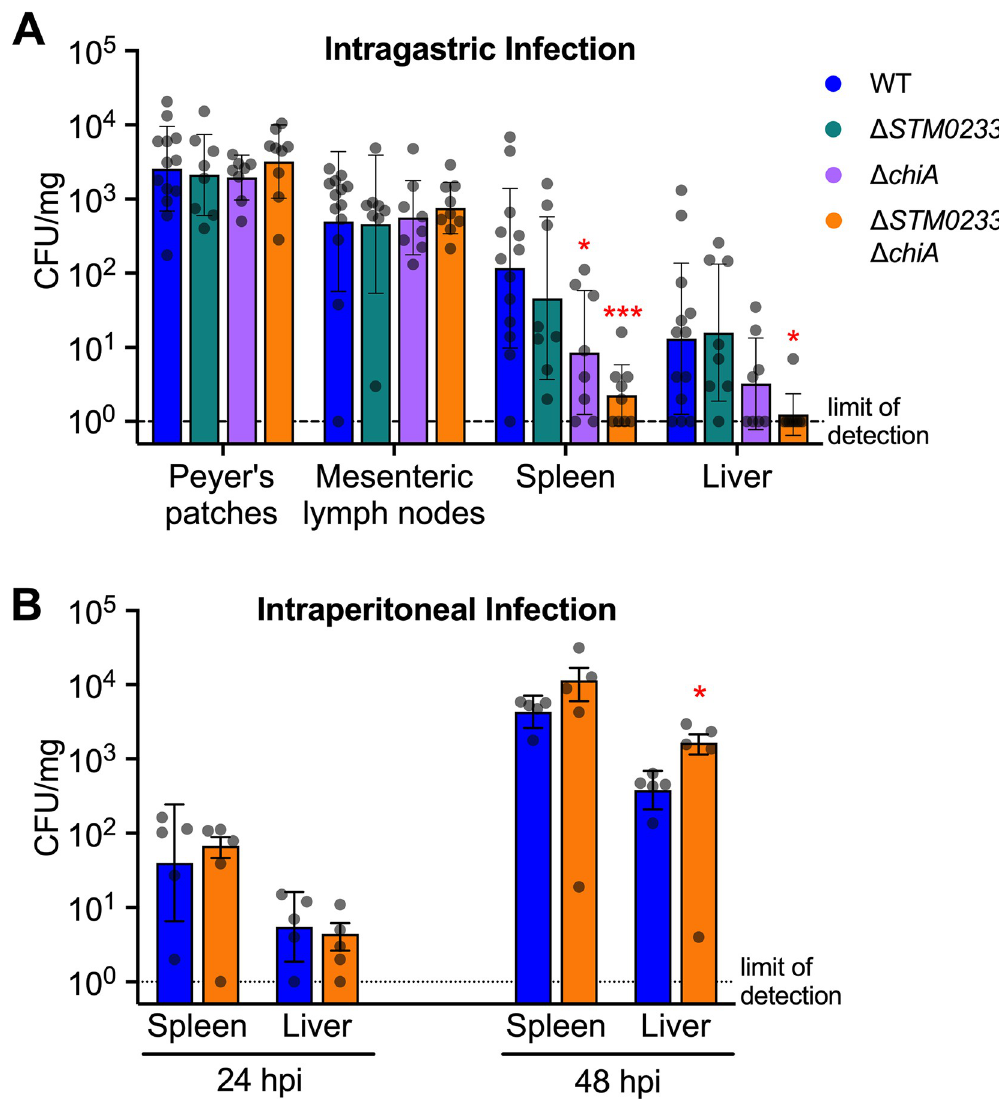
Fig 3. Chitinase-mediated invasion of intestinal tissue contributes to S . Typhimurium dissemination. (A) Colonization of the Peyer’s patches, mesenteric lymph nodes, spleen, and liver 48 h after intragastric infection. WT n = 13, Δ STM0233 n = 8, Δ chiA n = 8, Δ STM0233 Δ chiA n = 9. (B) Colonization of the spleen and liver 24 h and 48 h after intraperitoneal infection. n = 5. Bars represent geometric mean ± geometric SD. Statistics: Stars indicate significance compared to the WT control by one-way ANOVA with Dunnett’s multiple comparison test. � = p < 0.05, ��� = p <